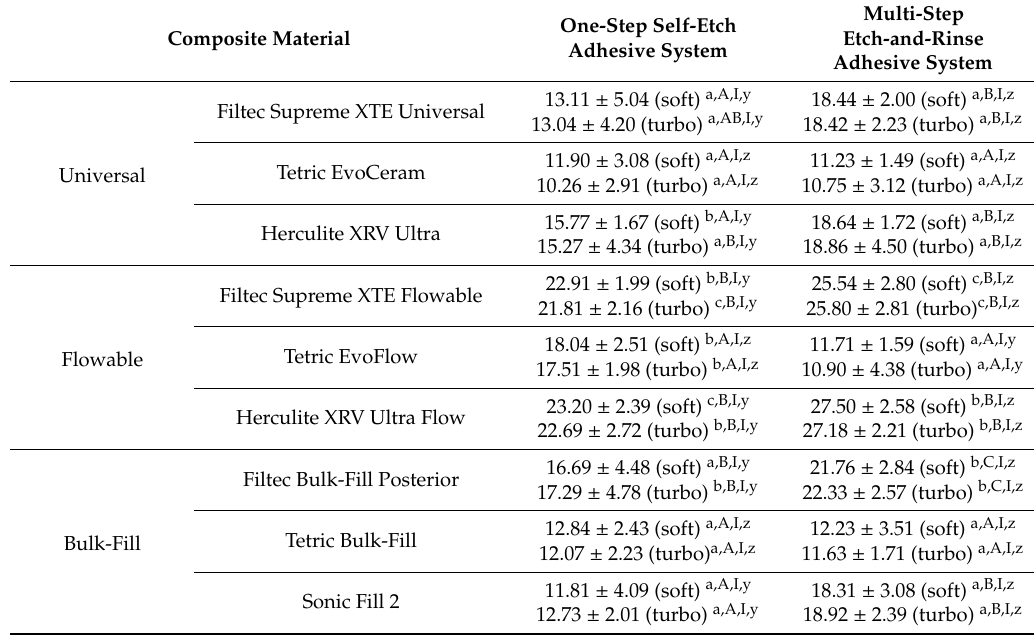
Table 1. Push-out bond strength (MPa) and standard deviations ( ± SD) for each tested group separately. Composite Material